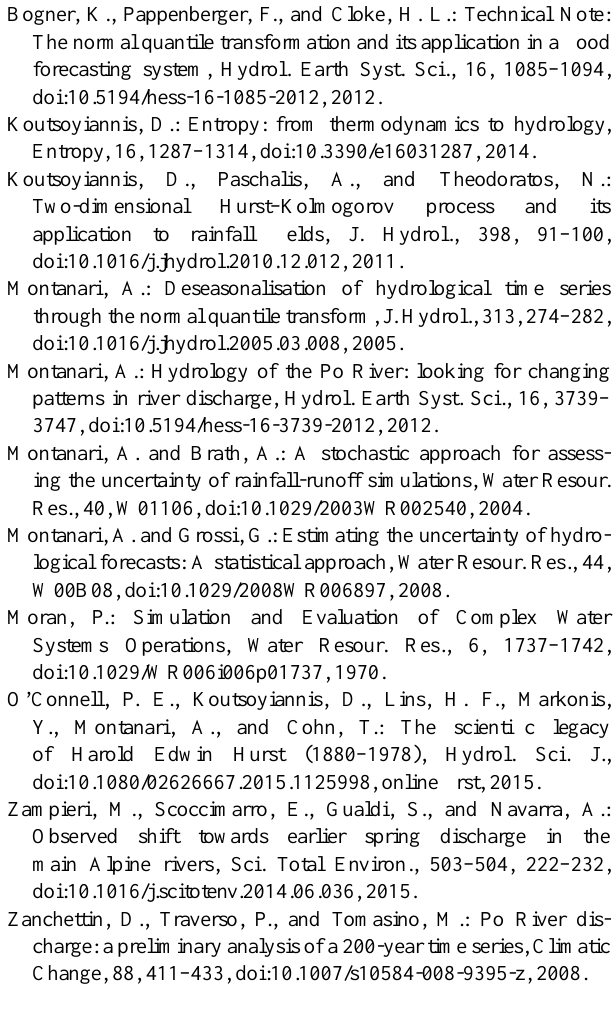
Figure 4. Peak flows in the flood season (October–November) vs return period modeled through the EV1 distribution